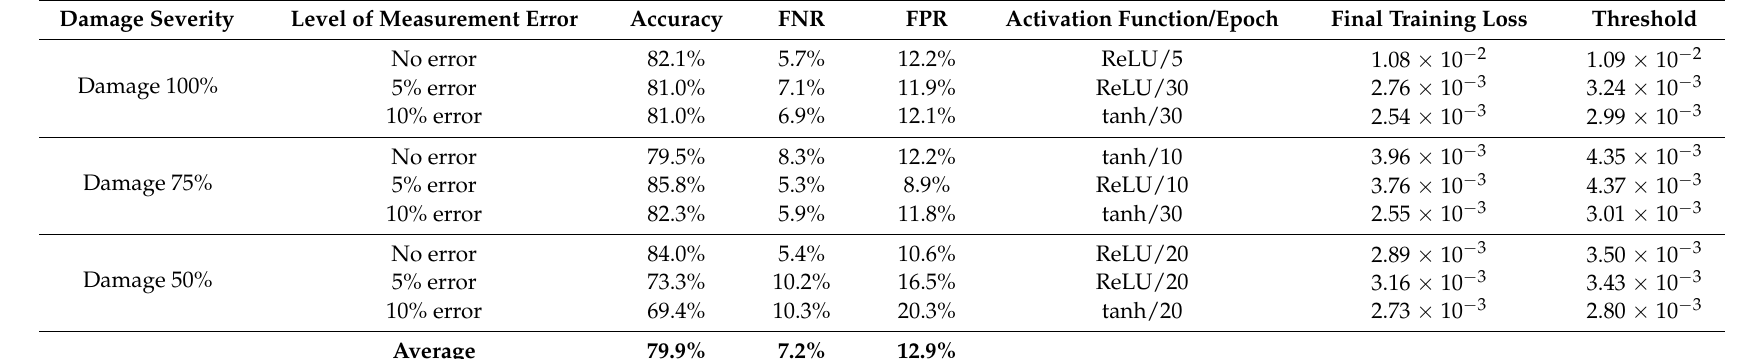
Table 3. Accuracies of the CAE models corresponding to three levels of measurement errors for the multi-vehicle traffic